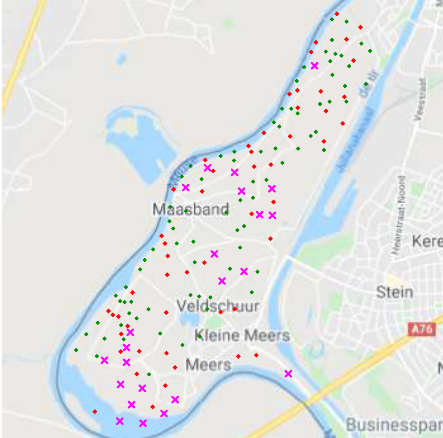
Figure 3. Area in the floodplain of the Meuse river considered for measurement of different pollutants at 155 sampling locations. The 132 points marked on the map display those sites taken for training, by using the values of cadmium and lead respectively collected at the 52 red points and 80 green points. The 23 crosses represent those locations used for